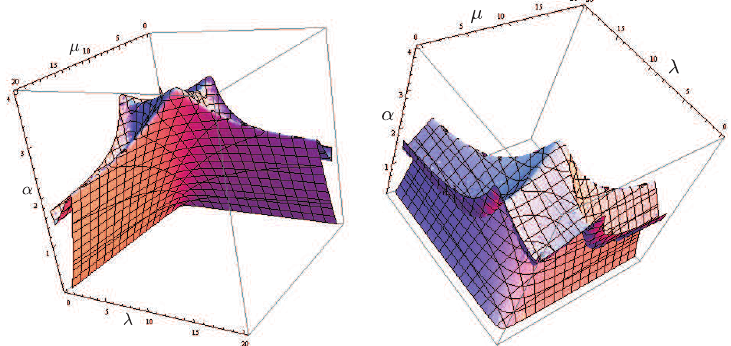
Figure 3. Two views of the solution surface F ± 1 of the problem (1.1), where f = g = x 1 3 + x 41 and b − a =